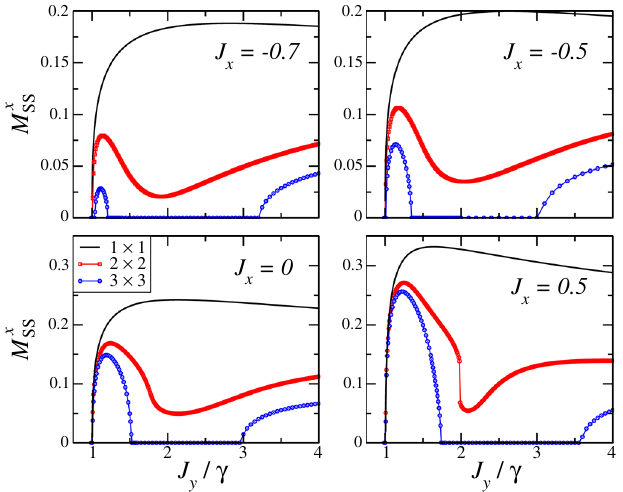
FIG. 9. Cluster mean-field analysis of the ferromagnetic order parameter in two dimensions, for four different vertical cuts of Fig. 8, at constant J x (the corresponding values of J x are indicated in the various panels). The various data sets denote different sizes of the clusters, up to l ¼ 3 .